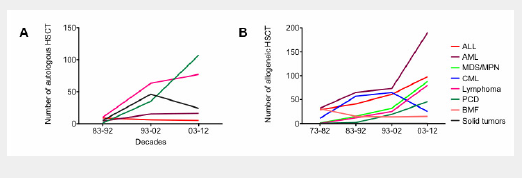
(A) Indications for autologous haematopoietic stem cell transplantation (HSCT) over the decades. (B) Indications for allogeneic HSCT over the decades. ALL = acute lymphoblastic leukaemia; AML = acute myeloid leukaemia; BMF = bone marrow failure; CML = chronic myeloid leukaemia; MDS/MPN = myelodysplastic syndrome / myeloproliferative neoplasm; PCD = plasma cell